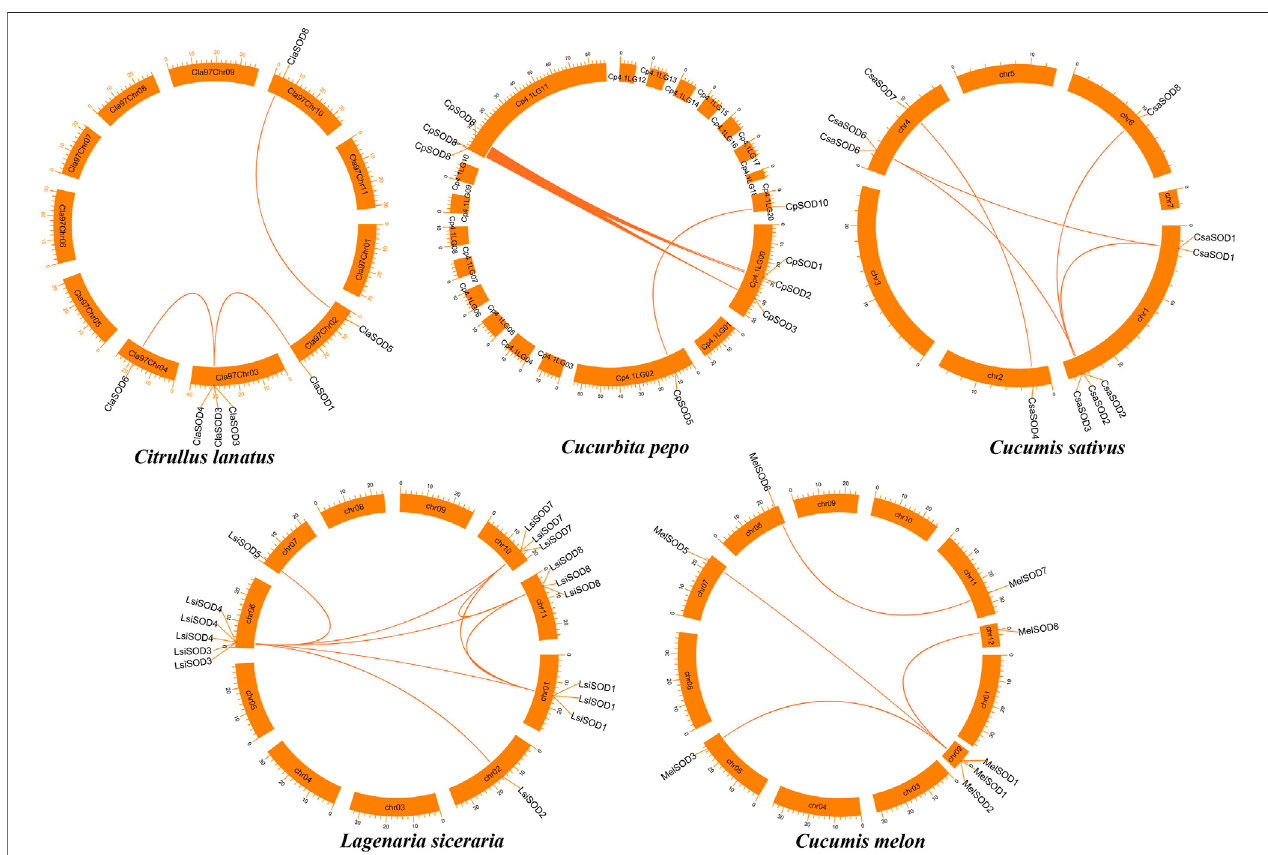
FIGURE 5 | Chromosomal localization and duplication events of fi ve Cucurbitaceae genomes and gene pairs are joined with a colored line.